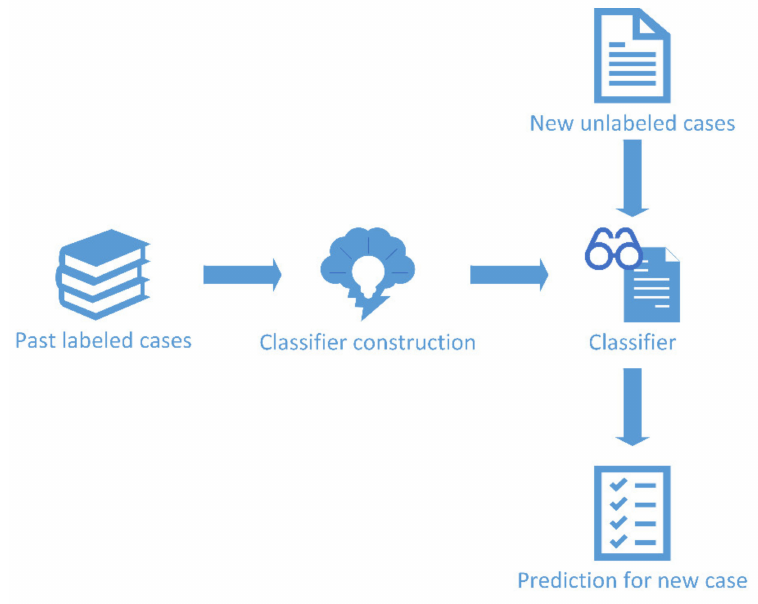
Figure 4. Classification